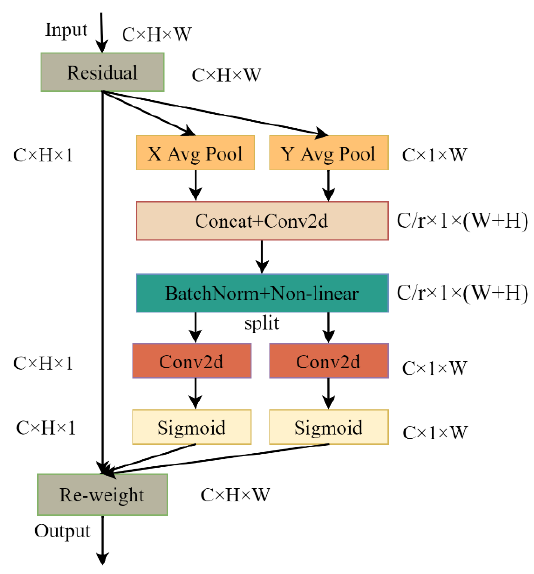
Figure 4. Coordinate Attention.